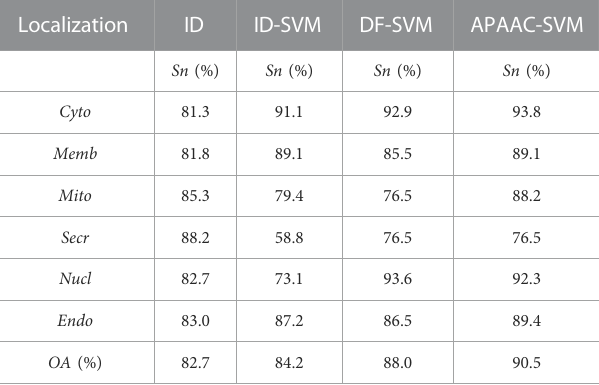
TABLE 1 The predictive results of the three datasets. Dataset